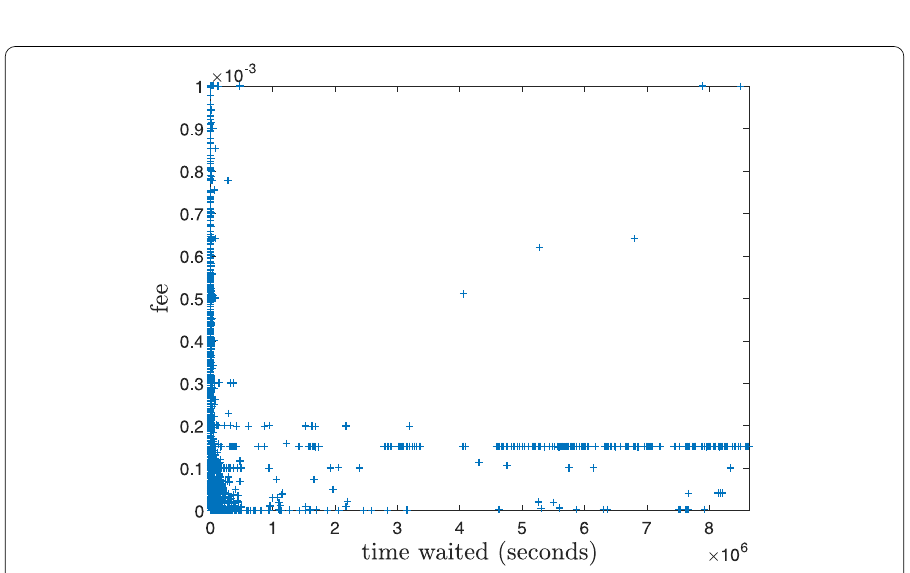
Figure 9 Fee vs time. Fee paid for a transaction vs. time waited before the transaction is registered in the